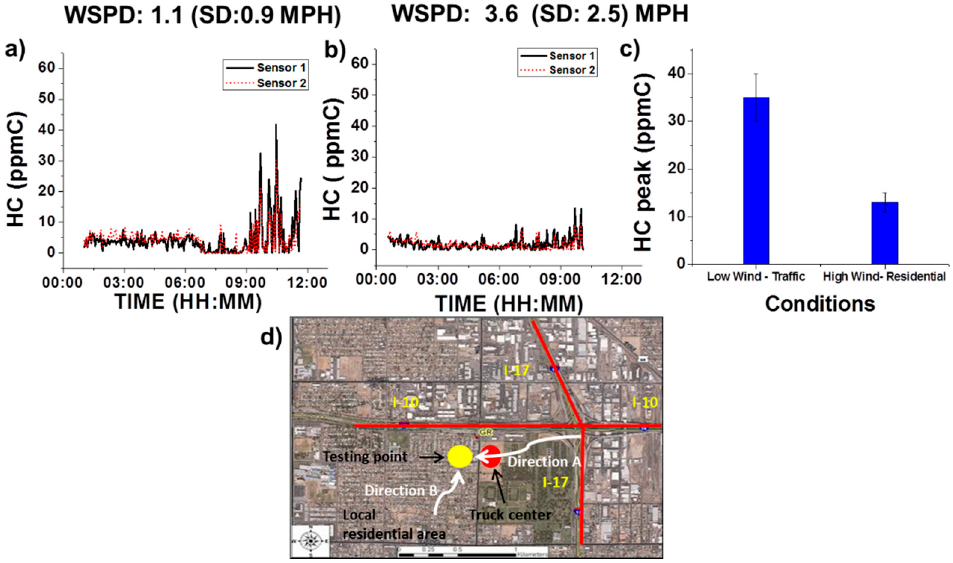
Figure 9. Wind speed and direction effect on VOC device performance. ( a ) HC concentration under lower wind speed and wind direction from areas with higher expected concentration (direction A showing in ( d ), ( b ) HC concentration under higher wind speed and wind direction from areas with lower expected concentration (direction B showing in ( d ); ( c ) peak HC values comparison; ( d ) a map showing the testing location and wind directions.